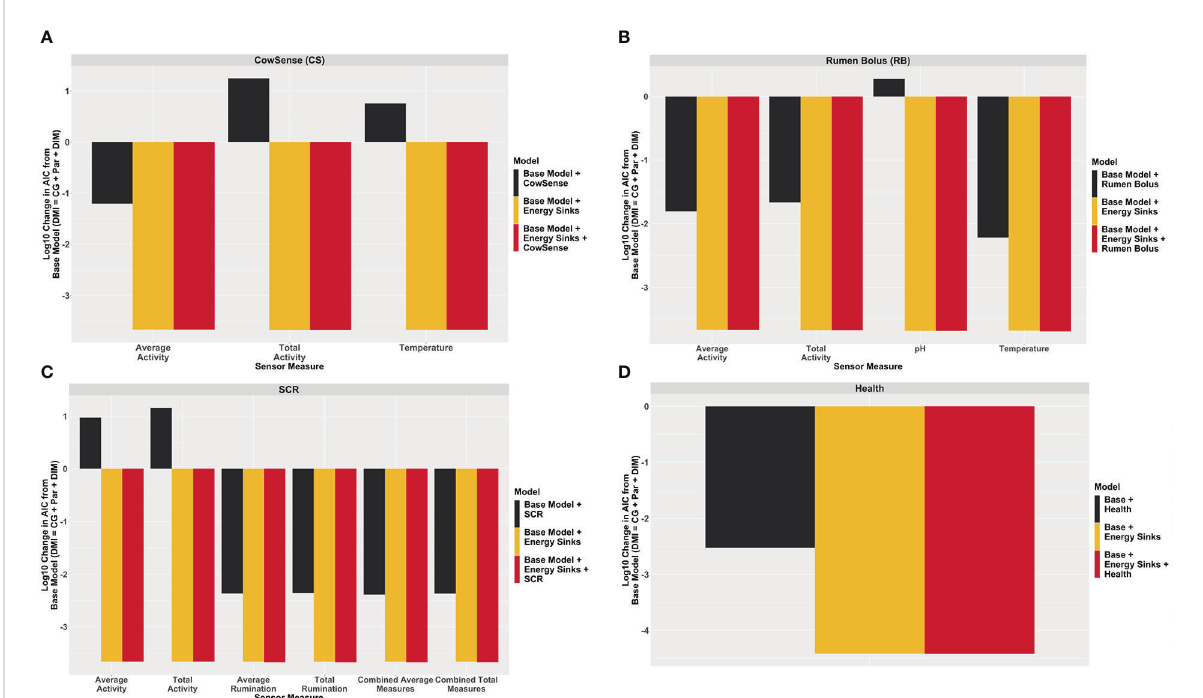
FIGURE 2 Evaluation of the impact of health disorders and sensor measures on model fi t when estimating dry matter intake (DMI). Changes in Log10 AIC were compared to a “ base model ” (dry matter intake = contemporary group + parity + days in milk). Lower (more negative) values indicate a larger improvement in model fi t as a result of the additional variables in the model. (A – C) Evaluate the impact of sensor measurements on model fi t, while panel (D) evaluates the impact of health disorder information model fi t. (A) Models estimating DMI including CowSense (CS) ear tag measures. A total of 93 cows had CS data, for a total of 4242 – 4331 days of data, depending on the measure. (B) Models estimating DMI including SmaXtec rumen bolus (RB) measures. A total of 56 cows had RB data, for a total of 2745 – 2885 days of data, depending on the measure. (C) Models estimating DMI including SCR ear tag measures. A total of 330 cows had SCR data, for a total of 10,284 days of data for all measures. (D) Models estimating DMI including health disorders. A total of 930 cows had health data, for a total of 45,023 days of